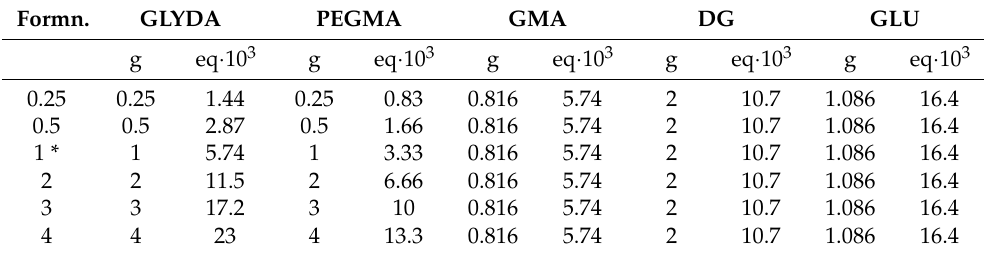
Table 1. Formulations with varied acrylate:epoxy ratios. Formn.